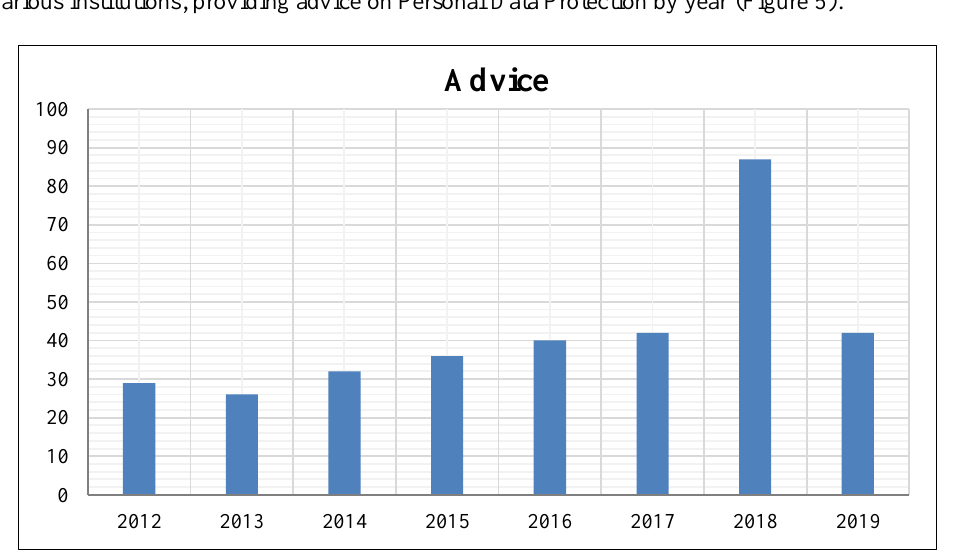
Figure 5. Graphic presentation of tips over the years by AIP